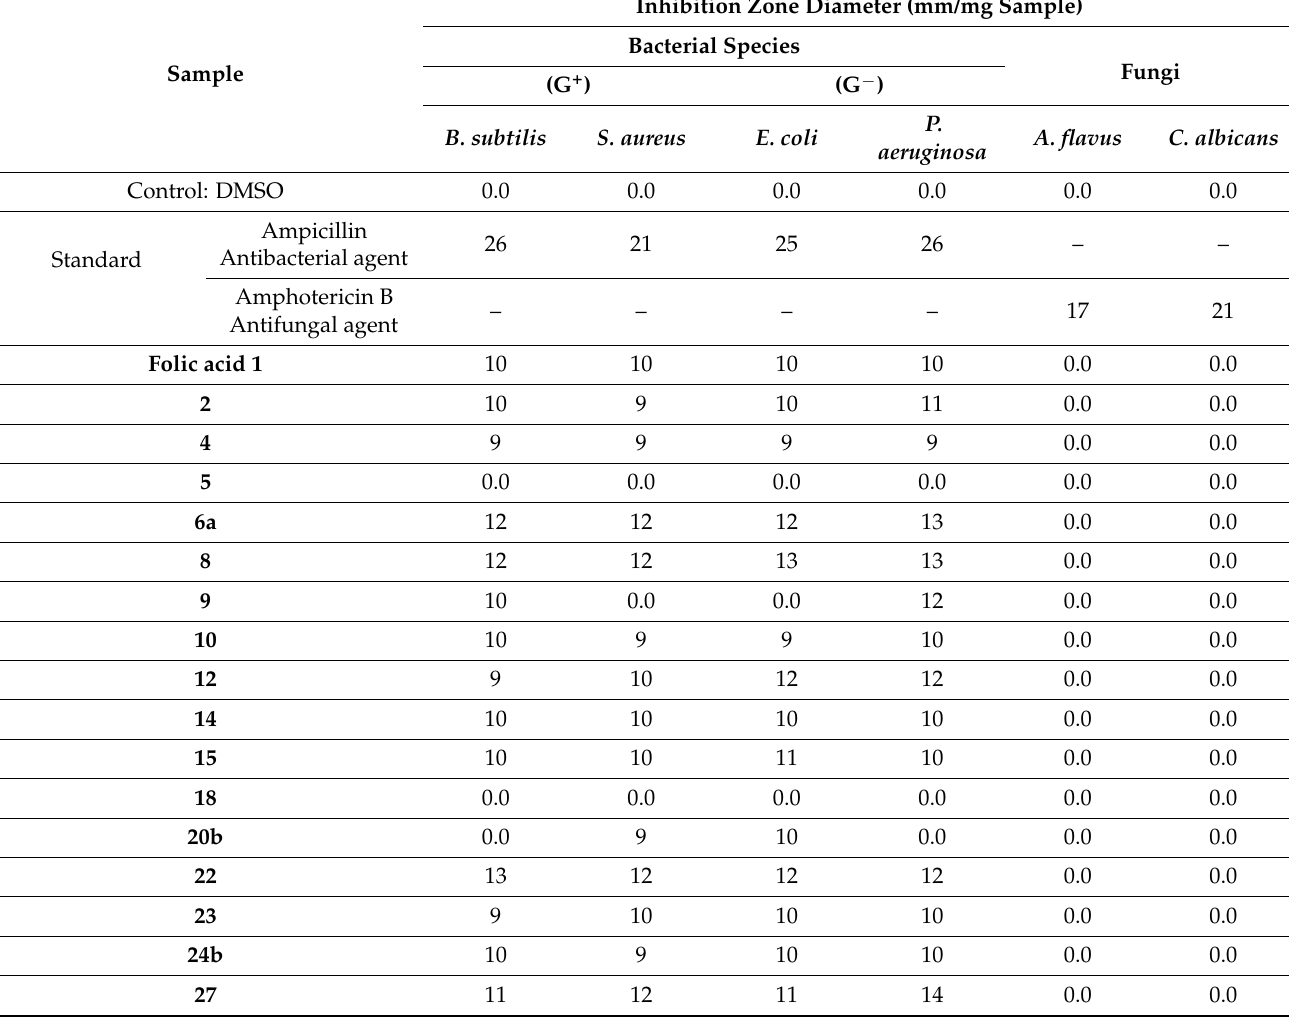
Table 1. Biological activity of some new synthesized